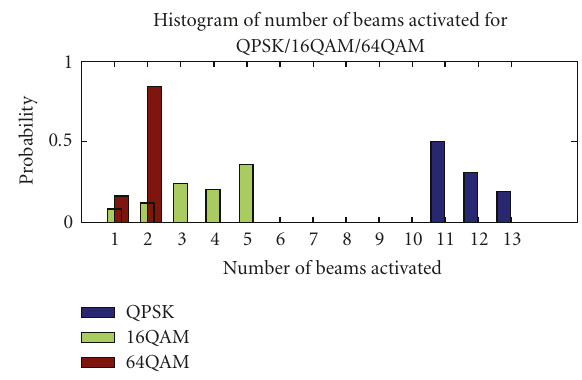
Figure 15: Histogram of numbers of beams activated from 64 QAM, 16 QAM, and QPSK modulation